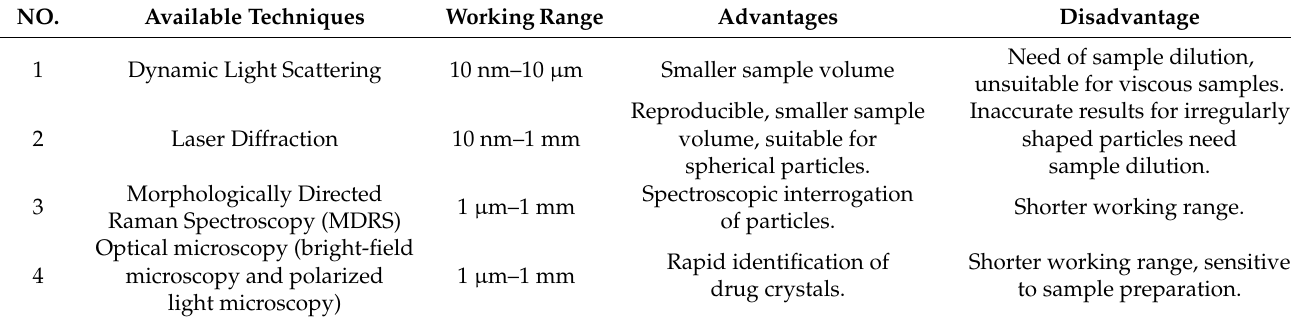
Table 2. Available techniques to determine the particle